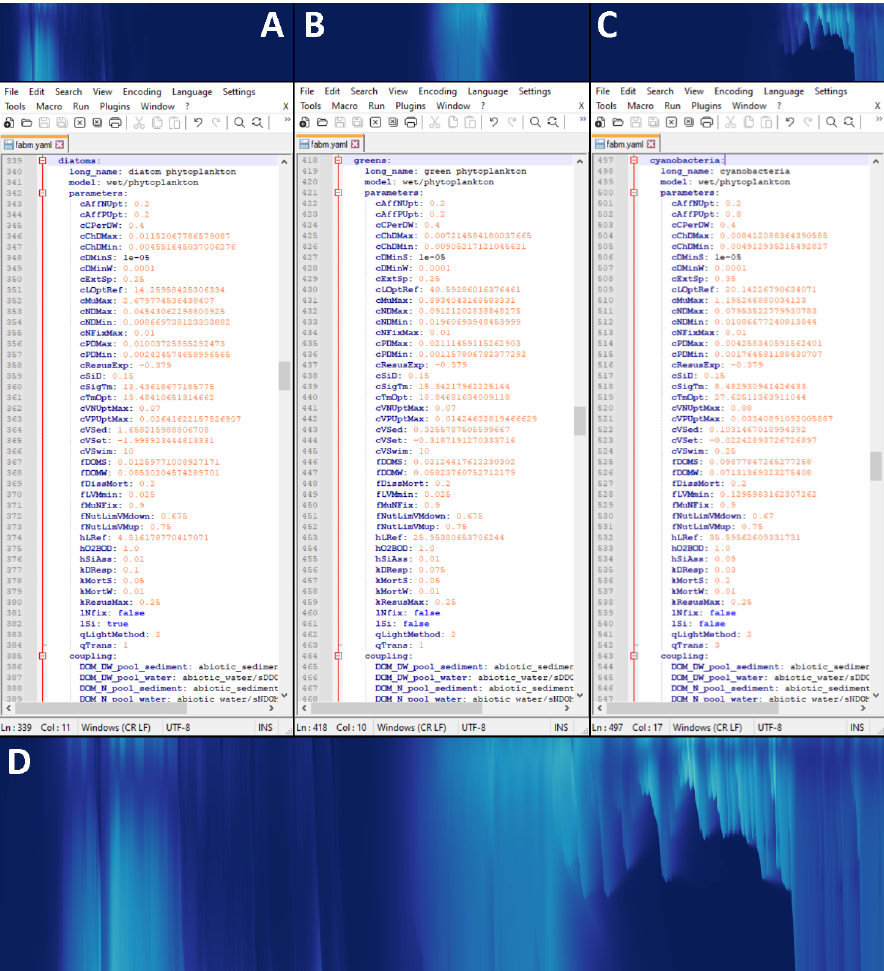
Figure 3. Modular configuration of phytoplankton instances in WET. Top row: individual chlorophyll a concentrations of diatoms (a) , green algae (b) and motile cyanobacteria (c) . Middle row: view of the section of the model configuration file corresponding to the panel above (file opened in the open-source text editor Notepad ++ v8.2.1). Bottom panel (d) : total chlorophyll a concentration for the upper 6m of Lake Bryrup for the year 1994, as simulated by WET coupled to the 1D GOTM lake model. Panel (d) is identical to Fig. 5e, and all axes and color maps in panels (a) – (c) are likewise identical to those of in (e) , except the period shown in this figure is 1 April through 1